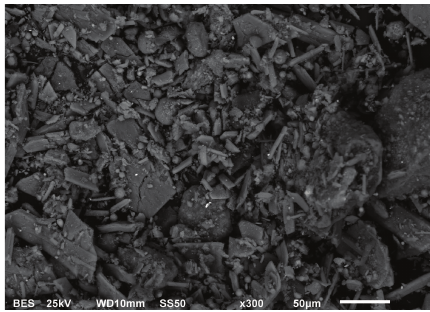
Figure 5: SEM image of FA-IW